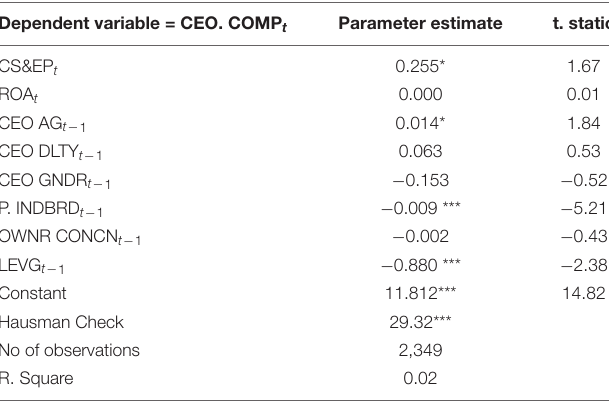
TABLE 8 | The impact of CS&EP on CEO